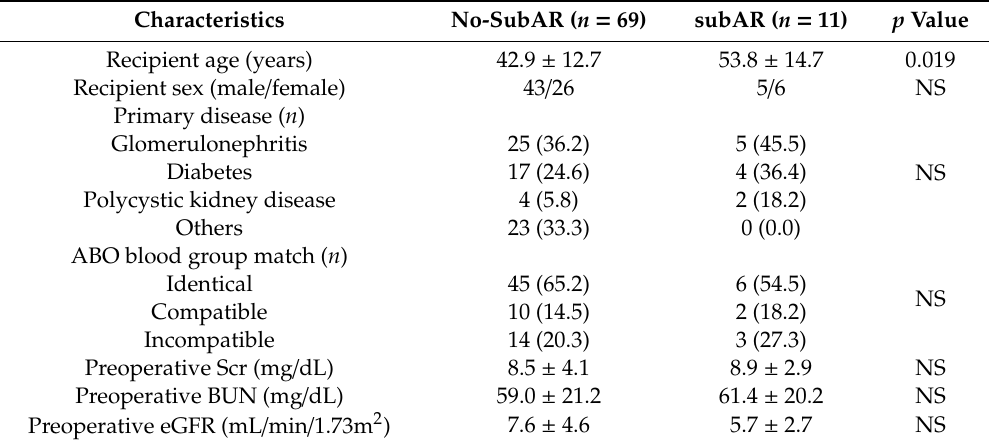
Table 1. Patient characteristics.